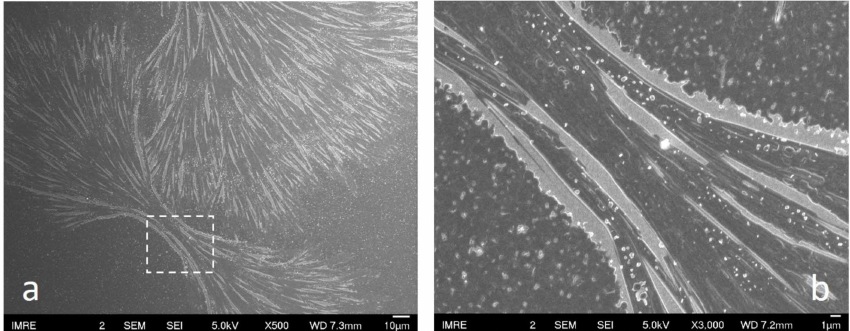
Figure 6. Large-scalemorphologychangesontheMAPbI 3 sampleafterwaterexposure. ( a )Spherulite-like pattern on the MAPbI 3 surface. ( b ) Zoomed image of the center of spherulite-like